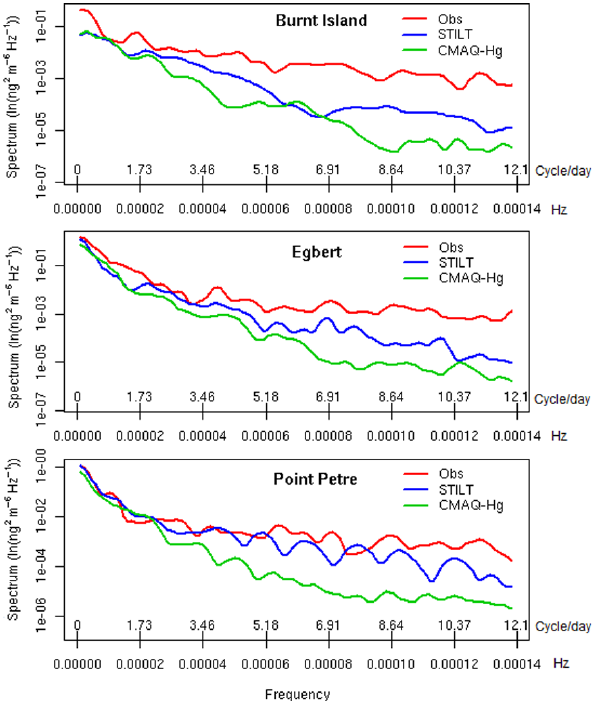
Fig. 5. Spectral densities of observed and simulated TGM concen- trations for the simulation period of 13–22 November